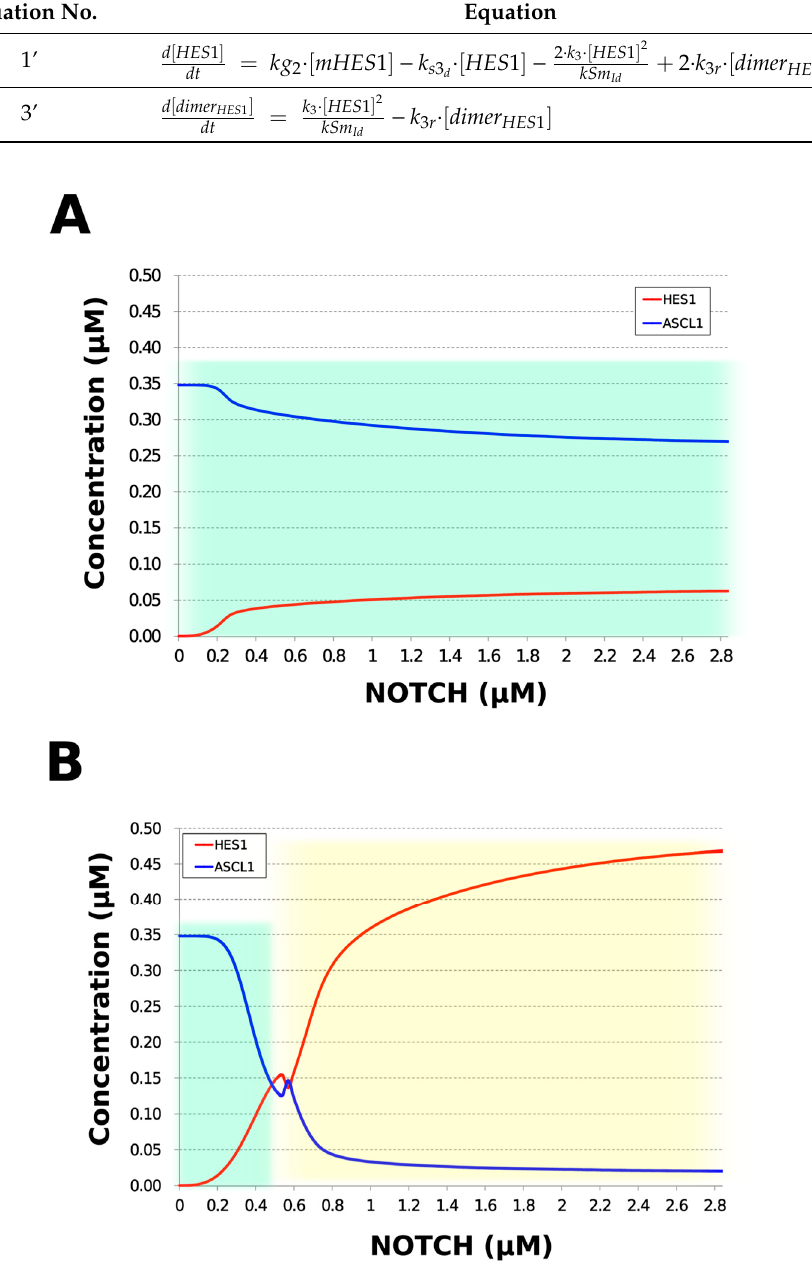
Figure 6. Simulation of HES1 and ASCL1 concentrations under the Id2 gene knockdown or overexpression conditions. ( A ) Id2 gene knockdown with kSm_Id = 0.1. ( B ) Id2 gene overexpression with kSm_Id = 10. Background colors show cell differentiation state; green, neuron; yellow, astrocyte. Table 3. Differential equations of a model with an incorporated inhibition of HES1 dimerization by Id2. Equation No.